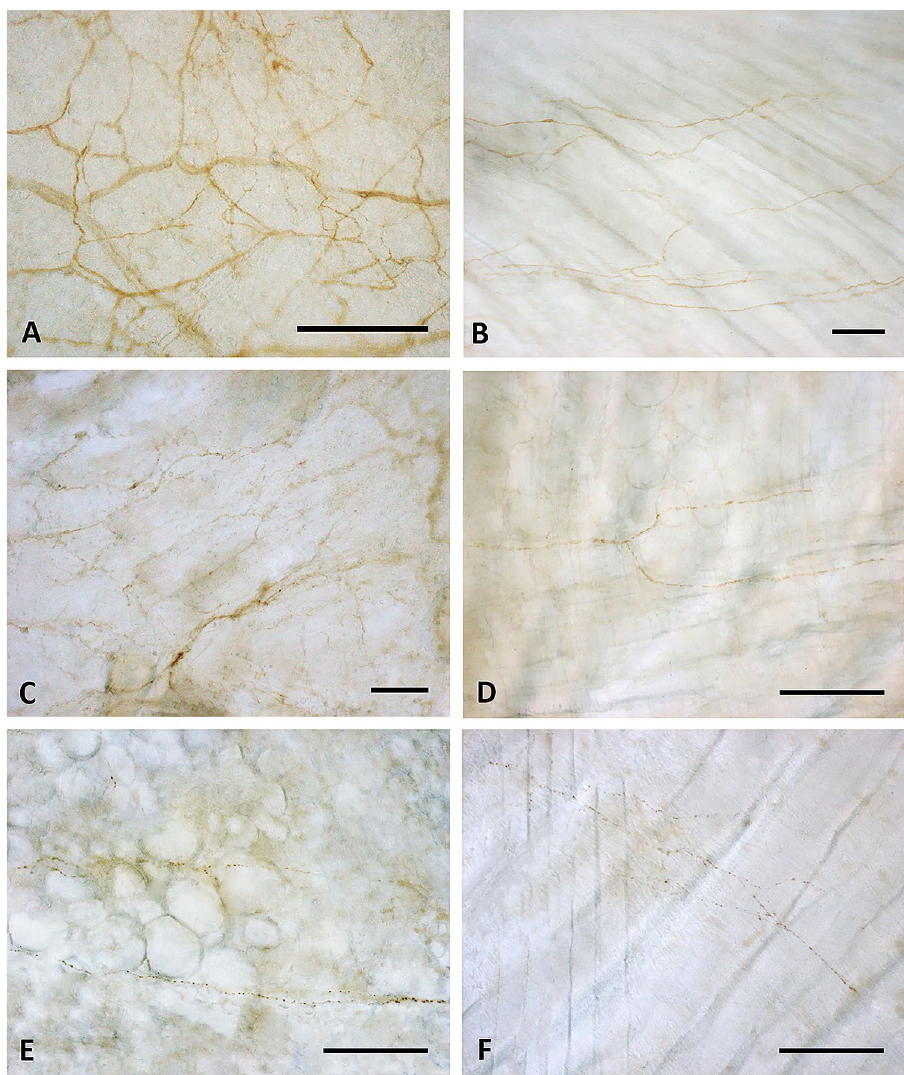
Figure 4. Innervation of thoracolumbar and gluteal fascia: Thoracolumbar fascia ( A , C , E ) and gluteal fascia ( B , D , F ) samples stained with S100 ( A , B ), PGP 9.5 ( C , D ) and Tyrosine Hydroxylase ( E , F ) antibodies. Scale bars: 100